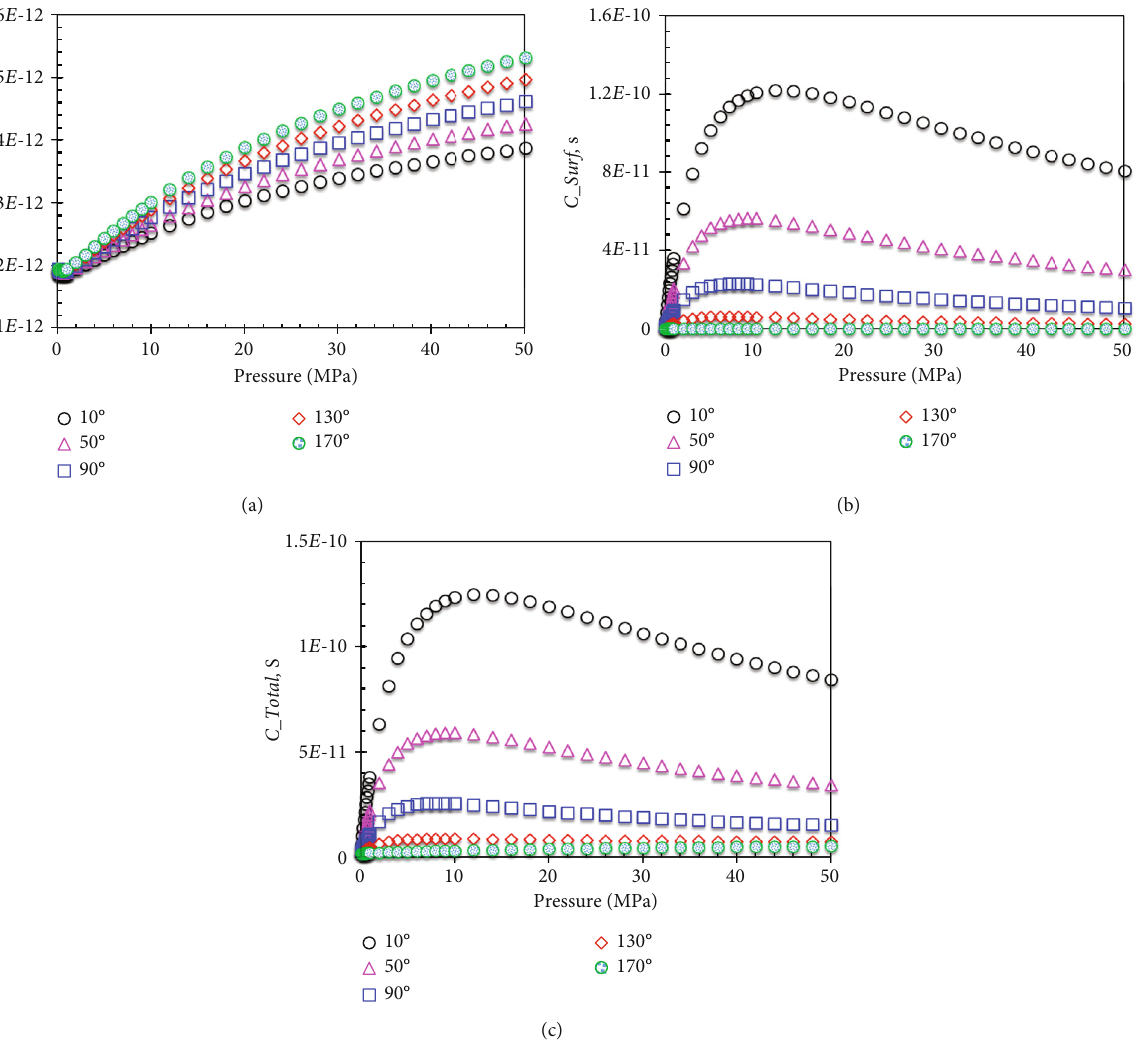
Figure 9: Wettability impact on gas transport through organic nanopore when pore size is equal to 2 nm: (a) Bulk-like gas conductance; (b) Surface di ff usion; (c) Total gas